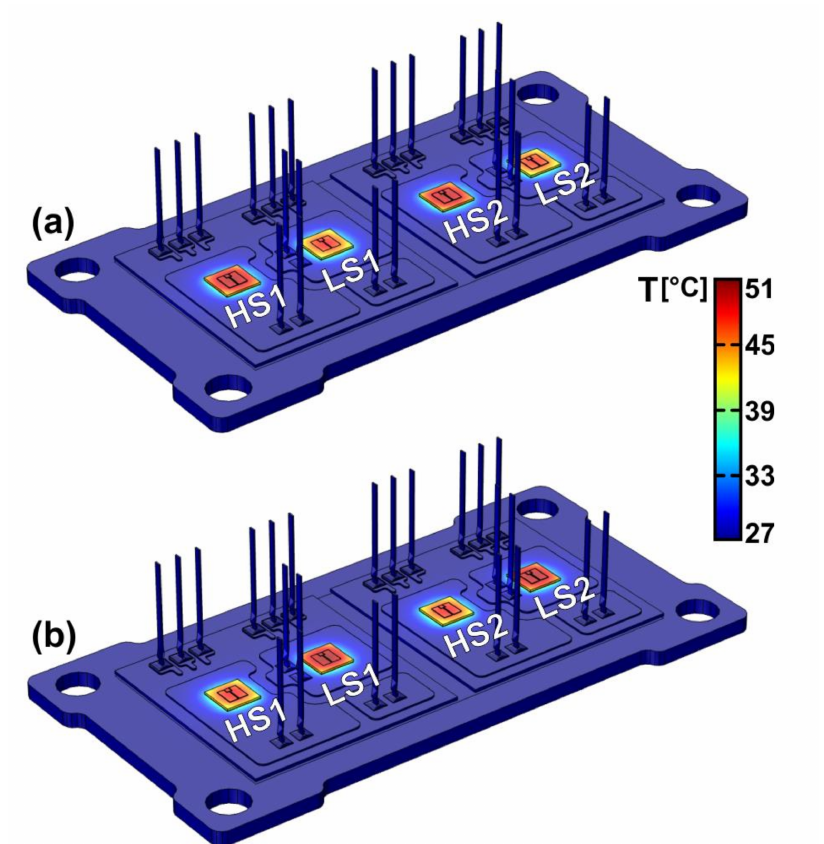
Figure 15. Nonlinear corrected spatial temperature distributions extracted by FANTASTIC in a post-processing stage. The maps correspond to the time instants ( a ) t = 987.0 ms and ( b ) 996.5 ms of the inverter simulation. The insulating gel is set as transparent for illustrative purposes. The location of LS and HS devices is also